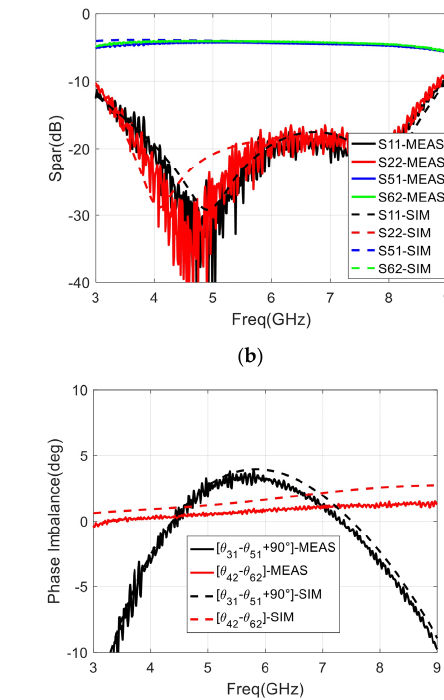
Figure 7. The block diagram of the detector circuit. In the detection circuit, three parallel filter capacitors are used in the design of LPF, and their capacitance values are 1.3, 2.0, and 4.7 pF, respectively, to prevent the output of the high-frequency signal. The measurement result of the designed LPF is shown in Figure 8a. It can be seen that the suppression of the RF signal by the LPF in the working frequency band (4–8 GHz) is greater than 19 dB. In addition, the analog integration circuit, which consists of a parallel 100 kΩ resistor and a parallel 100 pF capacitor, is located at the output port of the detector to meet the integration time requirements of the passive millimeter-wave imaging system [19,21,25]. In terms of detector input matching, common matching methods include impedance matching and microstrip stub matching [26–29]. The microstrip stub matching structure has the advantage of a small loss of signal, so the sensitivity of the detector will be relatively high, but the bandwidth of this matching method is limited, and the detection sensitivity fluctuates greatly in the working frequency band [29,30]. The impedance